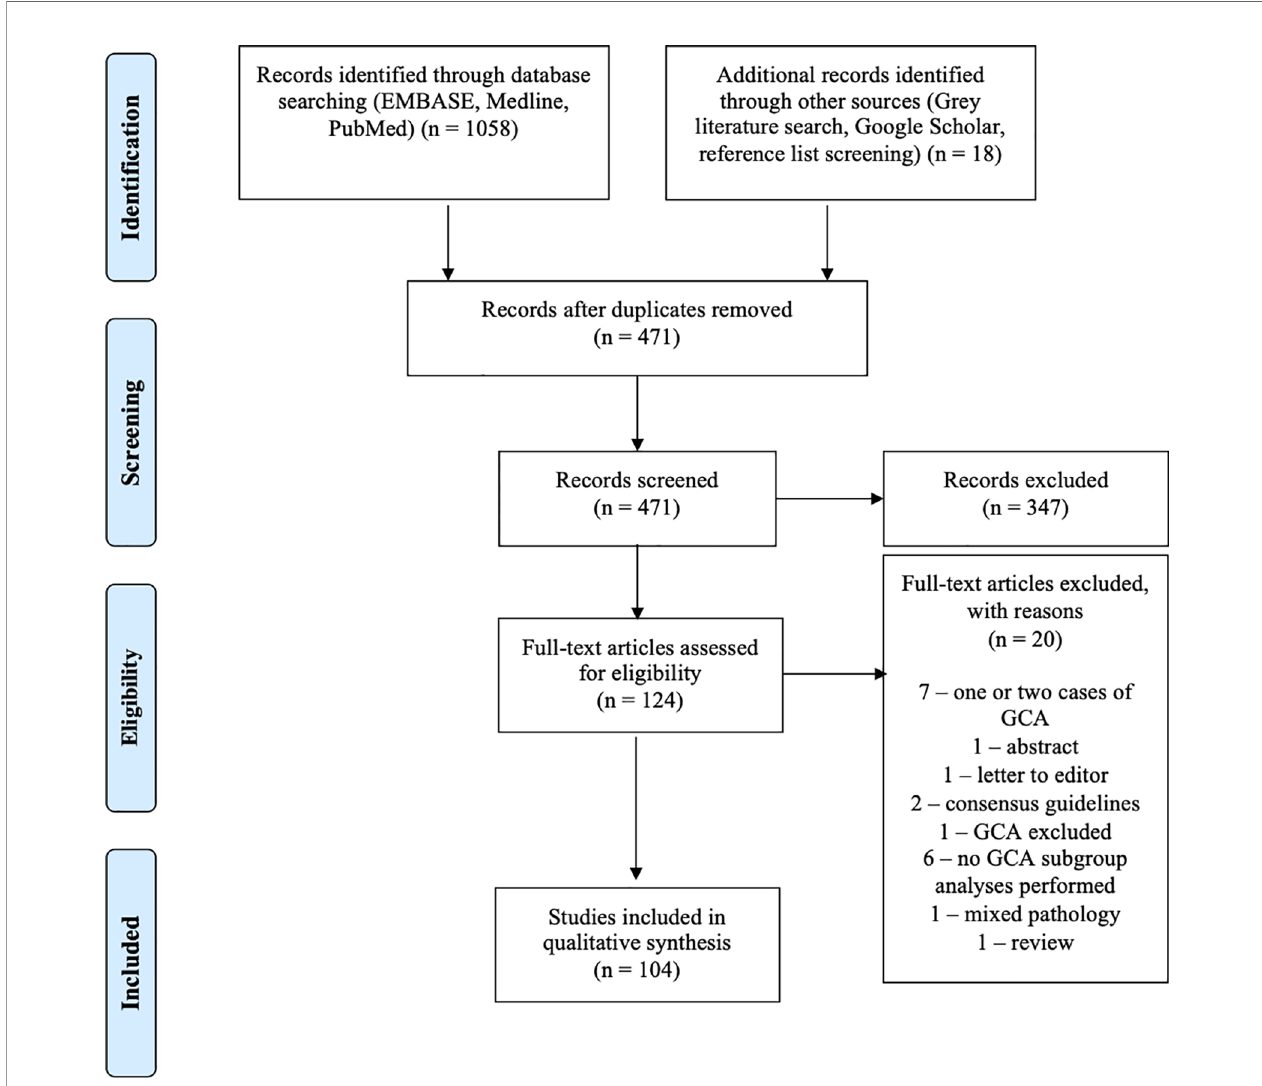
FIGURE 1 | Preferred Reporting Items for Systematic Reviews and Meta-Analyses (PRISMA) fl